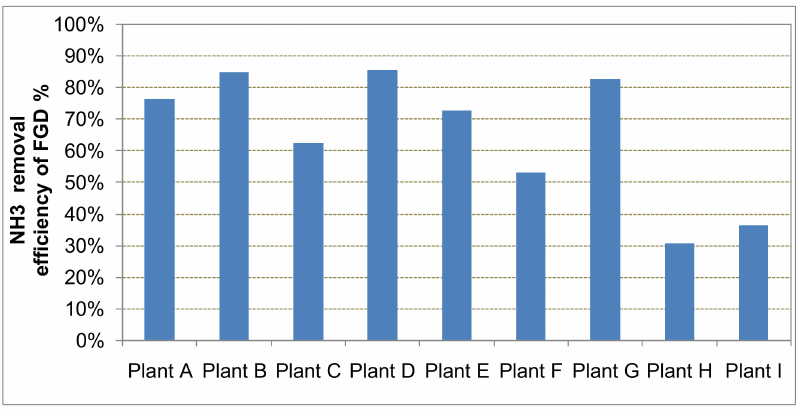
Figure 5. Ammonia removal e ffi ciency of wet flue-gas desulfurization